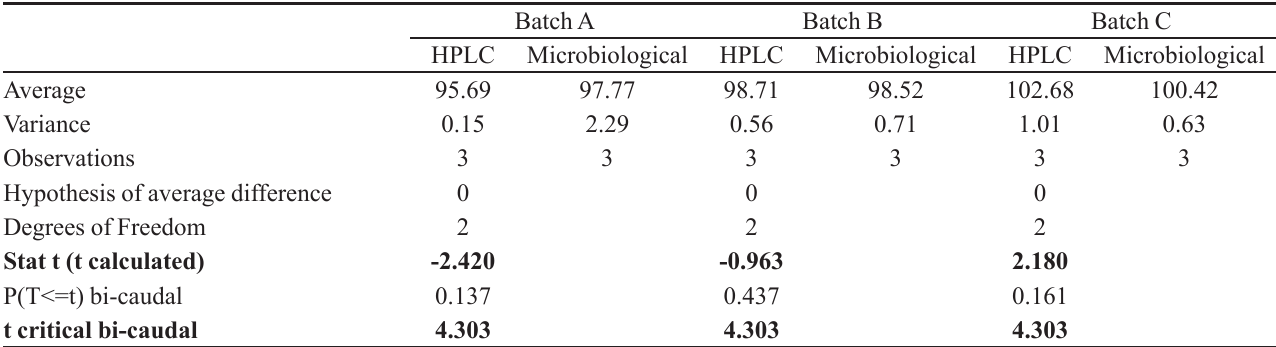
TABLE II - Statistical comparison between apramycin assay by HPLC method and by microbiological method for three batches of oral soluble